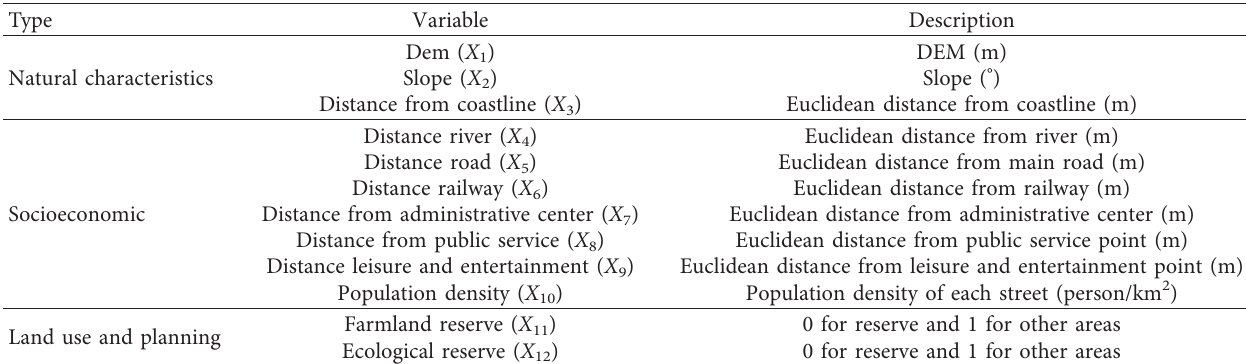
Table 3: Description of influencing